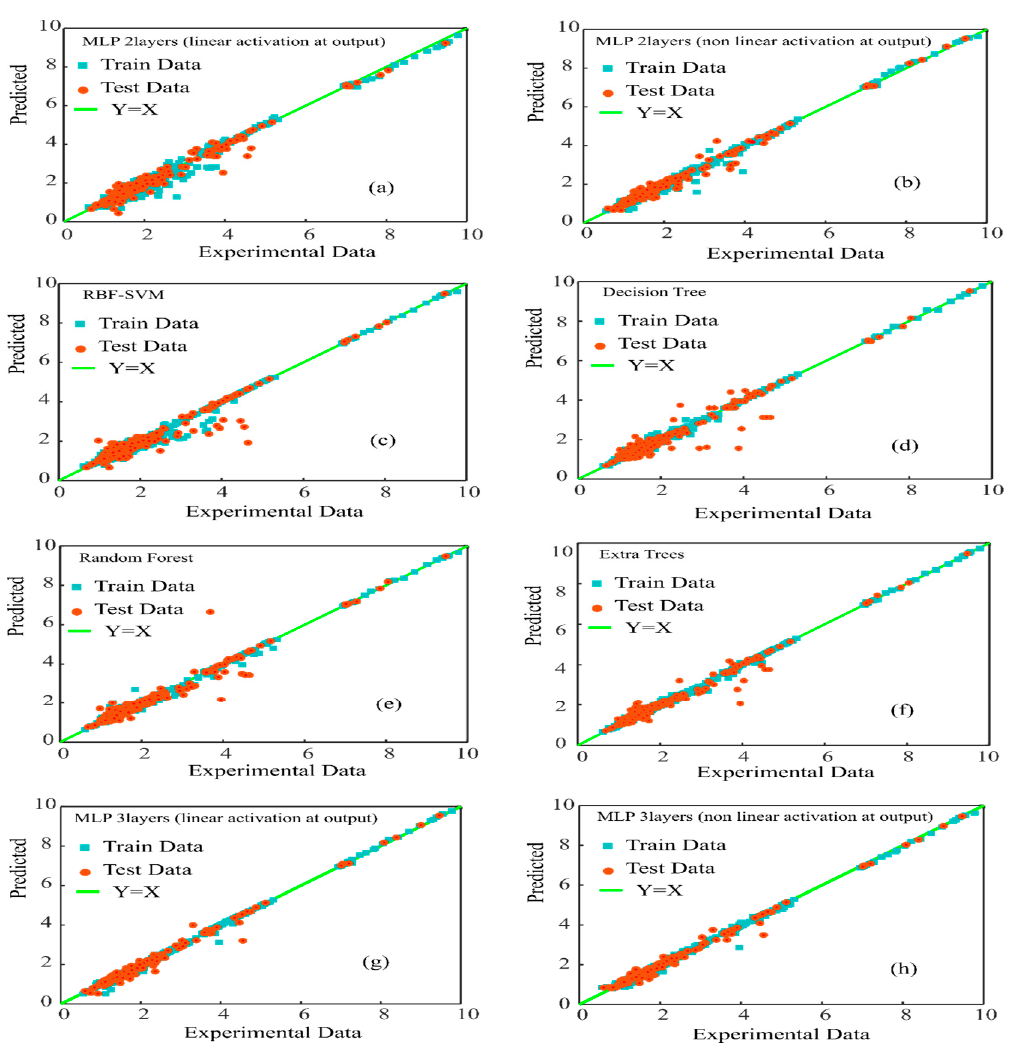
Figure 4. Cross plot of predicted viscosity versus experimental value, ( a ): MLP 2 layers (linear activation at output), ( b ): MLP 2 layers (non linear activation at output), ( c ): RBF-SVM, ( d ): Decision Tree, ( e ): Random Forest, ( f ): Extra Trees, ( g ): MLP 3 layers (linear activation at output), ( h ): MLP 2 layers (non linear activation at output).